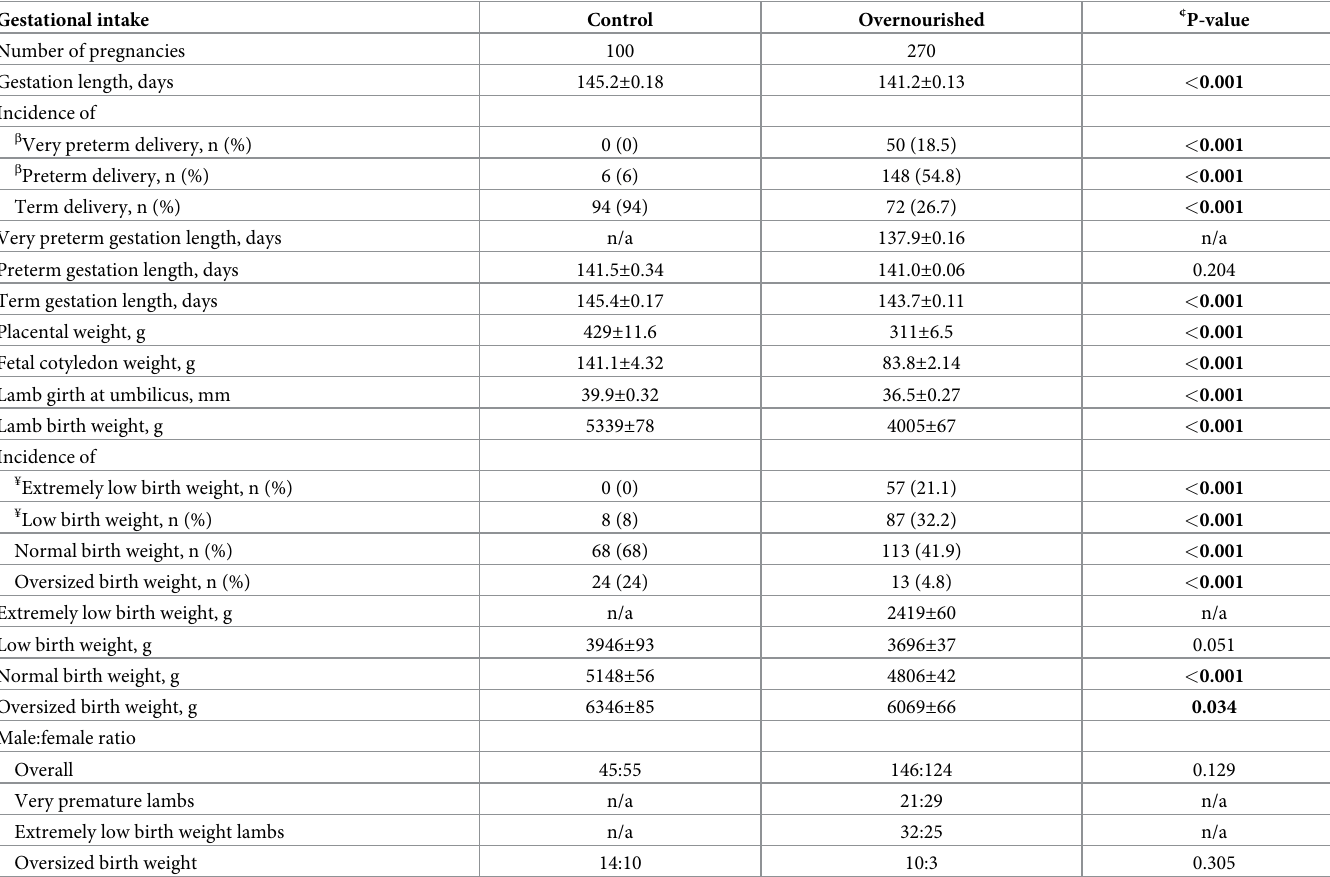
Table 1. Pregnancy outcome including the incidence and extent of premature delivery and prenatal growth restriction in singleton bearing adolescent ewes offered a control intake or overnourished throughout